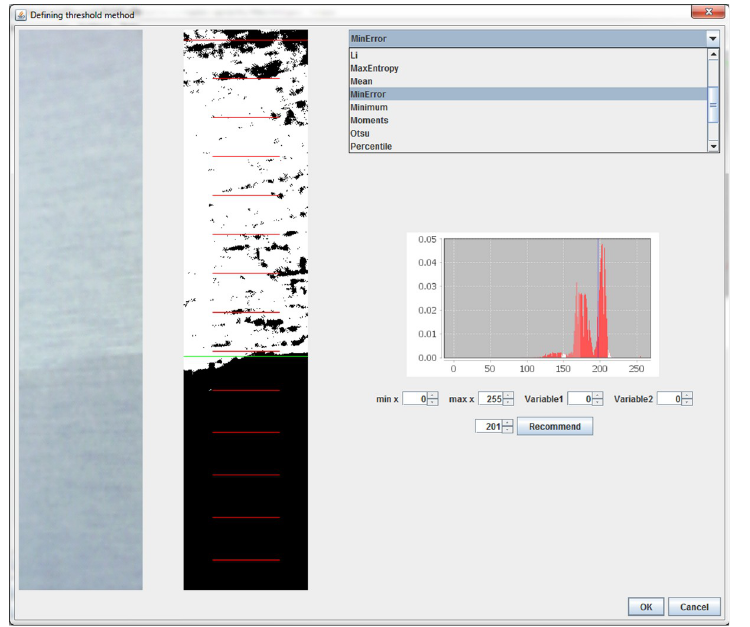
Fig 8. Choosing appropriate threshold